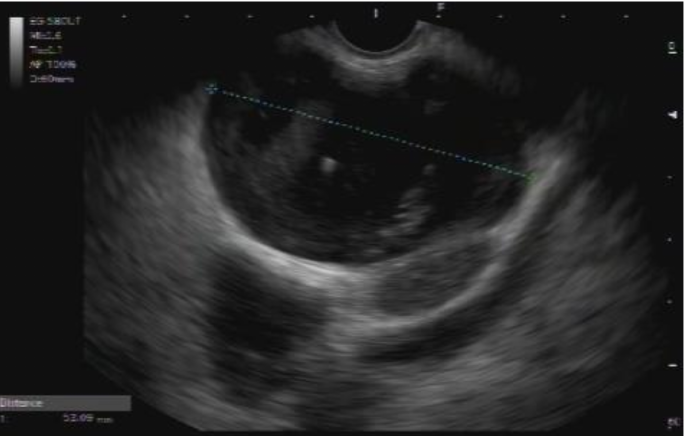
Figure 3. EUS demonstrates a 52 mm, mostly anechoic cystic lesion between the posterior gastric wall and the head/body of the